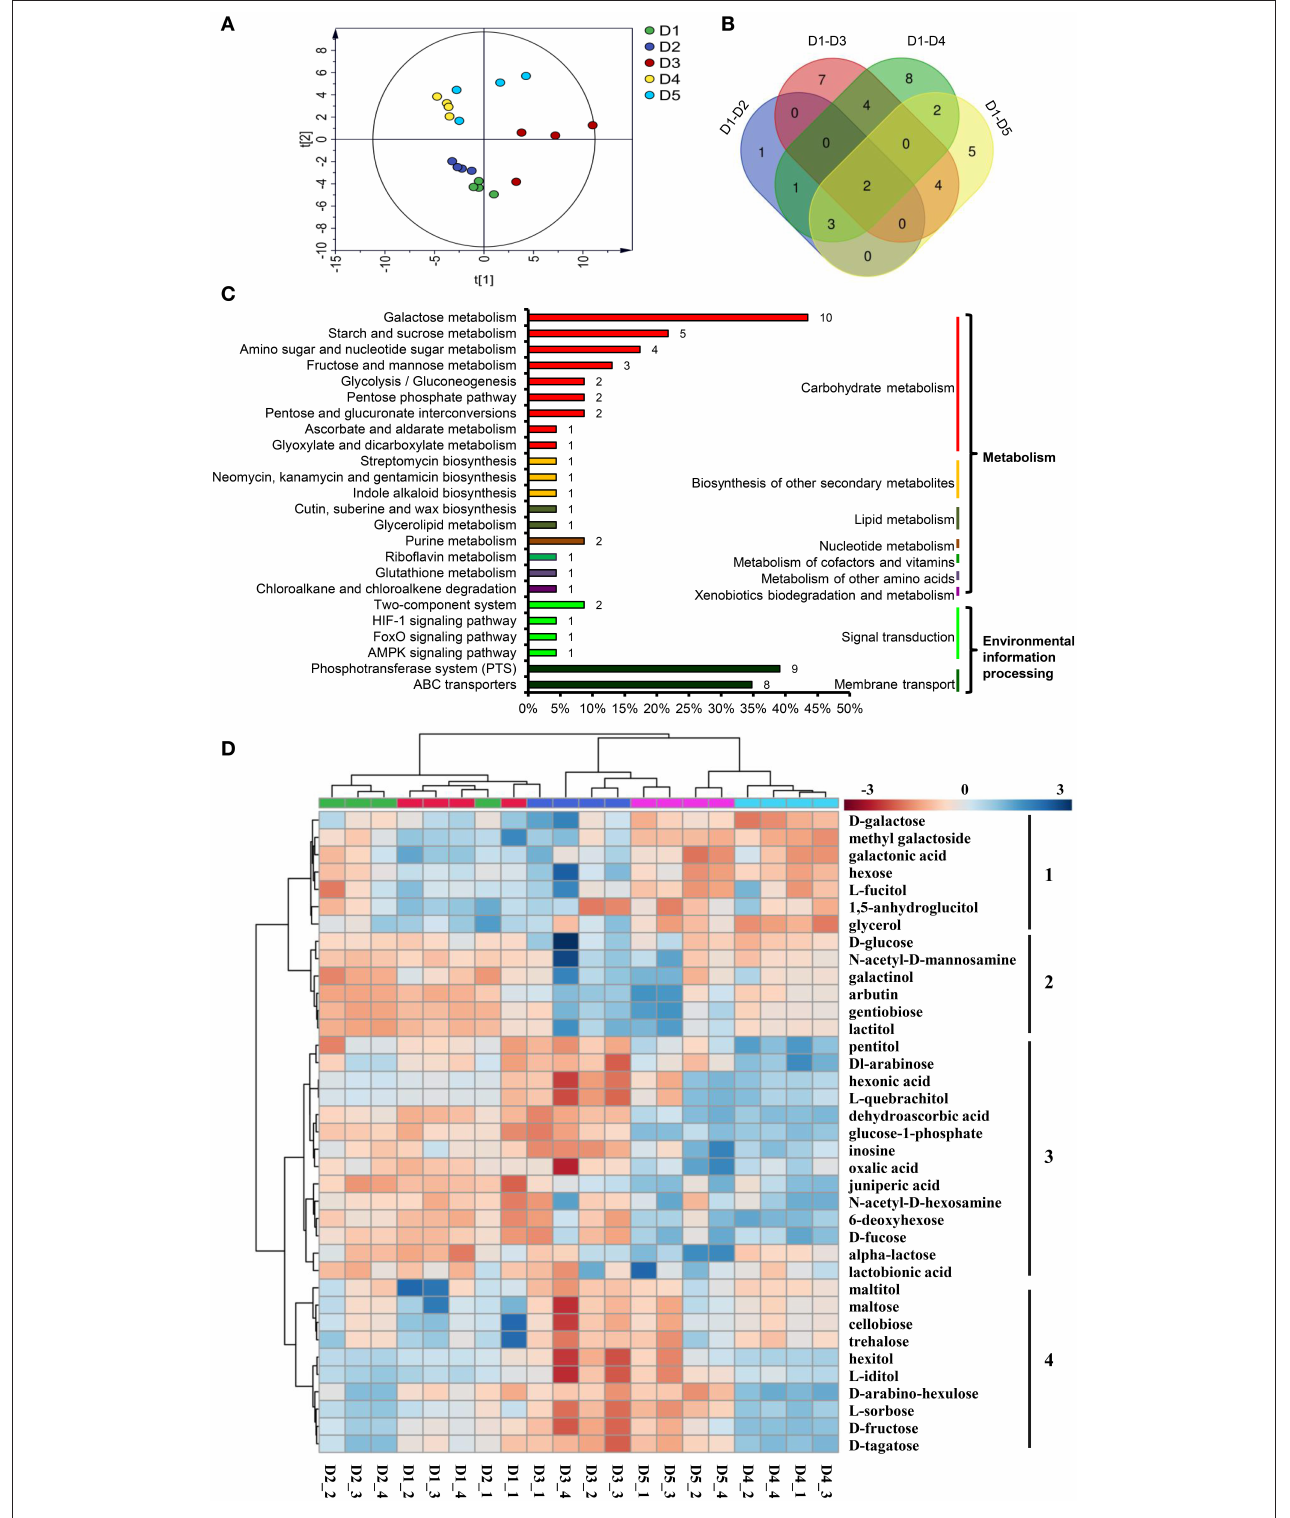
FIGURE 4 | DAMs in the fibrous roots of P. notoginseng grown at different planting densities. (A) Score plot of the PCA model of all samples. (B) Venn diagram of the DAMs in four pairwise comparisons. (C) DAMs involved in metabolic pathways. The ordinate is the pathway name, and the colored line on the right indicates